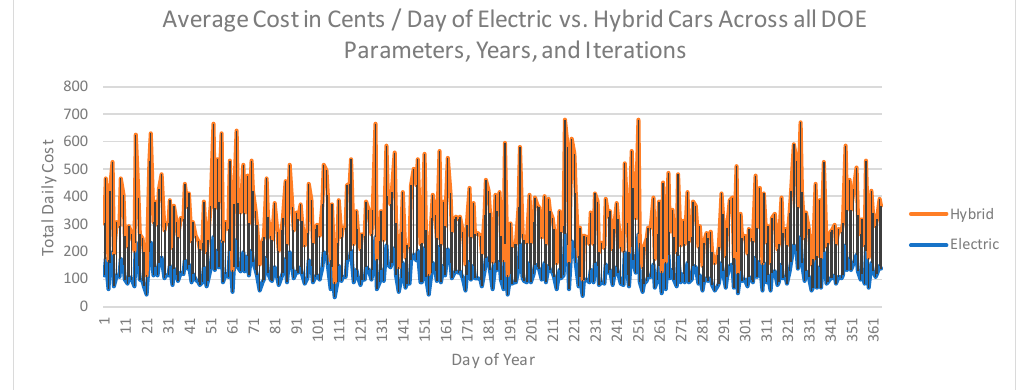
Figure 6. Time series for electric vs. hybrid car costs averaged over all design of experiments (DOE) parameters reveal that battery electric vehicles (BEV) variable costs are generally lower than plug-in hybrid electric vehicles (PHEV) costs. The black vertical lines represent the distance between the two cost structures.